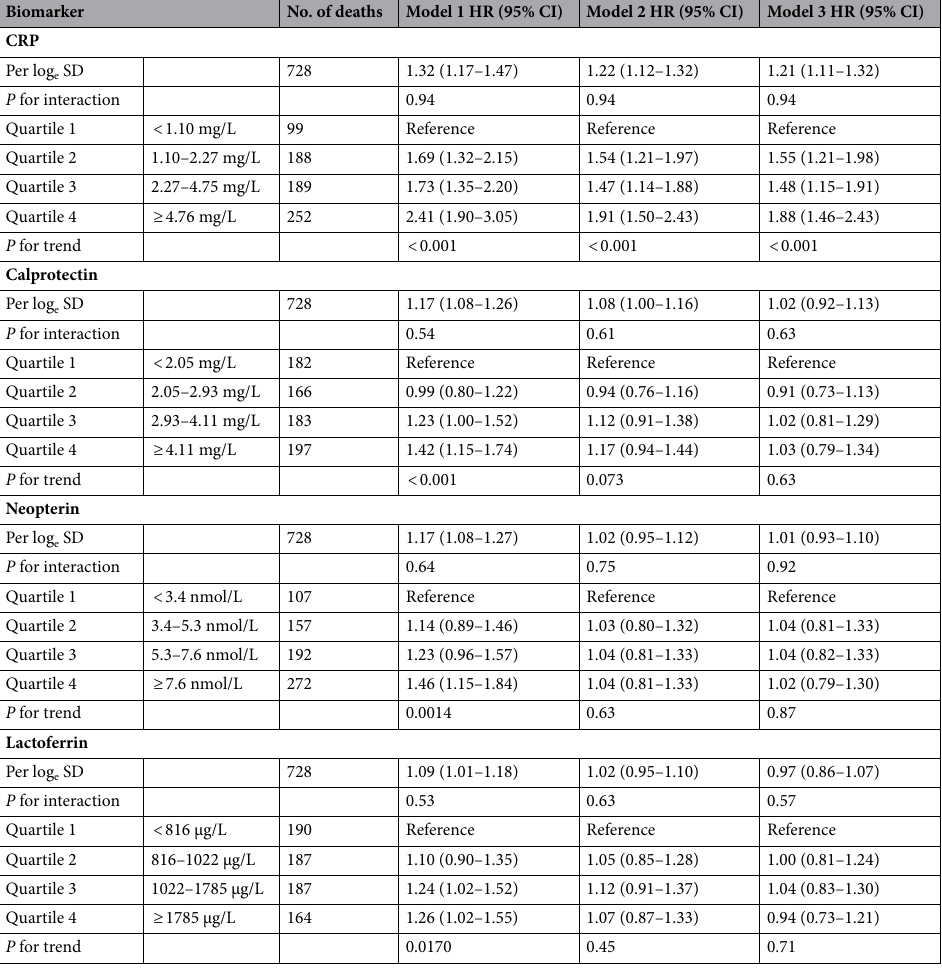
Table 2. Inflammatory markers and risk of cardiovascular mortality in overall study population. CI Confidence interval, HR Hazard Ratio, CVD cardiovascular disease. Estimated HRs per standard deviation (SD) increase by baseline log e concentrations, and within baseline concentrations (non-transformed) divided into quartiles. Model 1: Adjusted for age (as time scale), sex and diabetes. Model 2: Model 1 added prevalent CVD (self-reported history of myocardial infarction, angina pectoris or stroke), hypertension, smoking status, total cholesterol, HDL cholesterol, triglycerides, creatinine and body mass index (BMI). Model 3: Model 2 added the other 3 inflammatory markers. P for interaction: statistical significance testing interaction between diabetes and each inflammatory marker. P for trend: statistical significance of linear trend across quartiles of each inflammatory